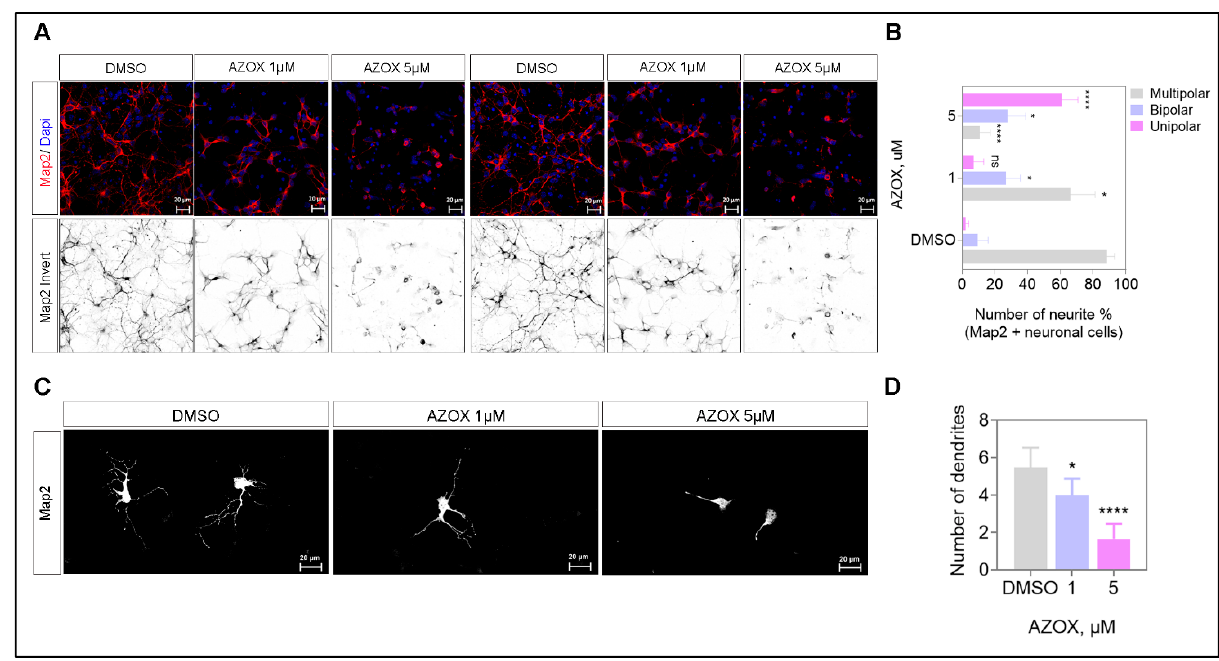
Figure 4. AZOX inhibits neurite formation in primary neurons. ( A , B ) primary neurons were cultured and exposed to 1 and 5 μ M AZOX for 24 h and stained with the Map2 (red), Dapi (blue), scale bar corresponds to 20 μ m. Azoxystrobin 1 μ M and 5 μ M reduced the dendritic complexity. Histograms show quantification of dendritic complexity in primary neurons, data are presented as mean ± SEM. ( C , D ) Quantification of dendritic numbers in AZOX treated neurons, scale bar corresponds to 20 μ m. The histogram represents the quantification of dendritic numbers in primary neurons; data are presented as mean ± SEM; t -test: * p < 0.05, **** p < 0.0001.